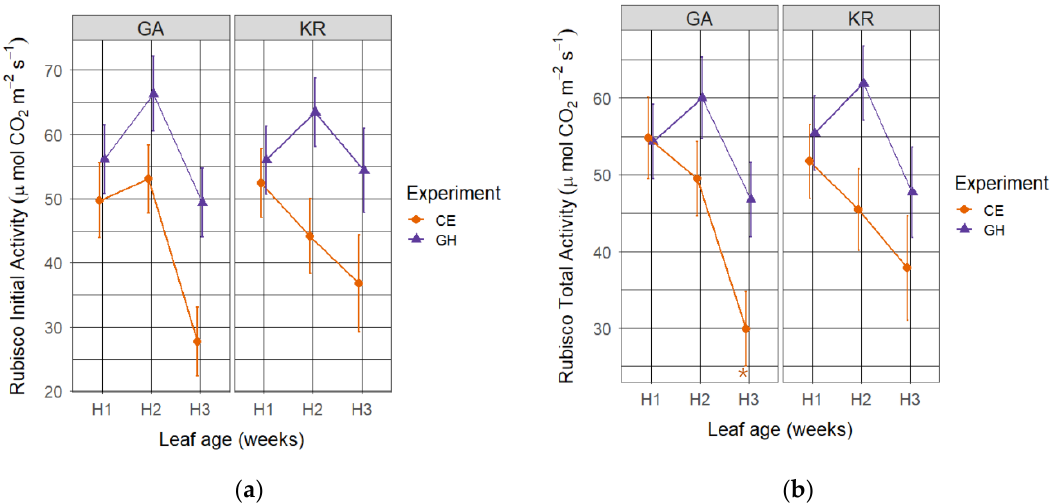
Figure 5. The impact of leaf age on Rubisco initial ( a ) and total ( b ) activities in two wheat cultivars (KR, Krichauff; GA, Gatsby) grown in the glasshouse (GH) or controlled environment (CE) room. The orange asterisk indicates significant difference from H1 in the CE experiment. Samples were taken from young expanding (H1-21 DAS), fully expanded (H2-28 DAS) and mature (H3-35 DAS) leaves after gas exchange measurements were completed under growth conditions. Data points represent the means ± standard errors of 6 biological replicates.